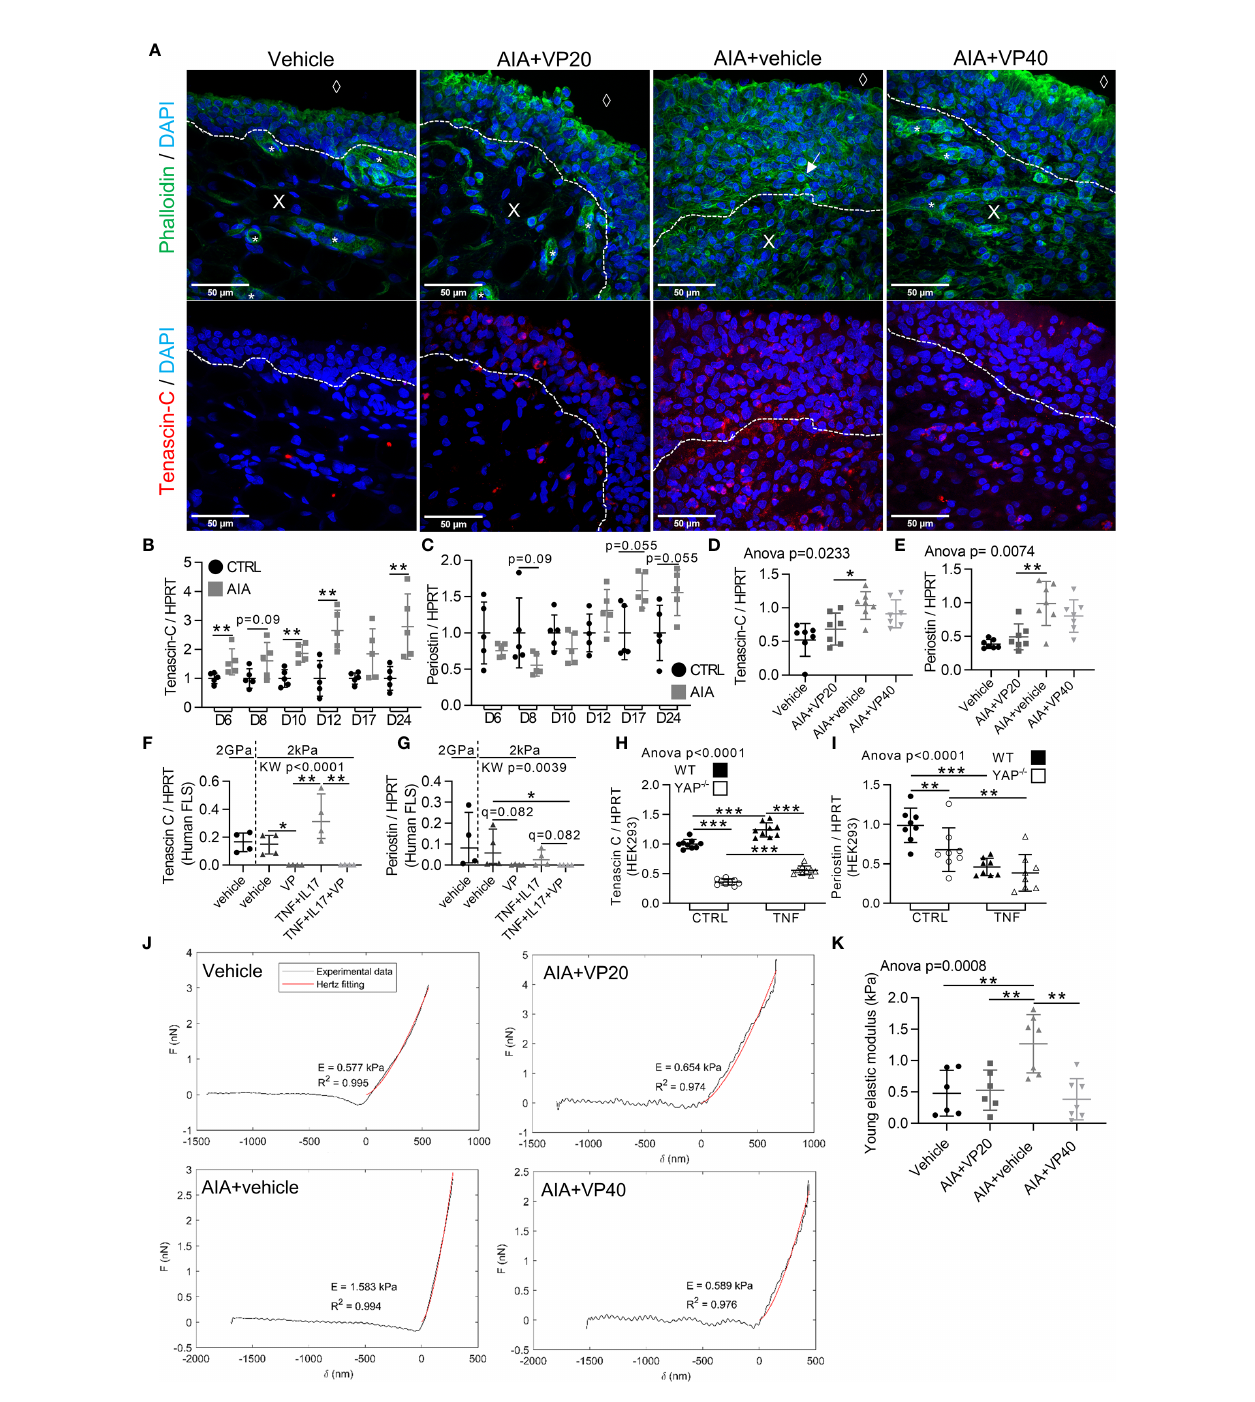
FIGURE 6 | Increased stiffness of synovial tissue during arthritis under the control of YAP/TAZ. Samples used for in vivo experiments were described in Figures 1 and 4 . RA FLS (n=4 patients) were used as described in Figure 2 . HEK293 results are representative of three independent experiments (n=9 per group). (A) Representative confocal tiled images of tenascin-C (red), counterstained with DAPI (blue) and phalloidin (green) in synovial membrane of rat AIA model; dotted lines: limit between synovial lining layer and synovial stroma; X: stromal compartment; diamond: synovial fl uid compartment; star: blood vessels; arrow: actin stress fi ber. (B – I) RT-qPCR results for tenascin-C and periostin in AIA and control rats ankle with different kinetics (B, C) VP AIA treated rats ankle (D, E) ; RA FLS (F, G) or HEK293 WT and YAP -/- cells (H, I) . (J) Representative punctual nanoindentation curves for rat synovial membrane using AFM. Increased slope corresponded, when fi tted with Hertz model (red), to an increased Young ’ s modulus (indicated as E ) (K) Corresponding quanti fi cation of Young ’ s modulus (kPa). Data were presented as individual values with mean ± SD (D, E, H, I, K) or median and interquartile range (B, C, F, G) with Kruskal Wallis or ANOVA test with FDR post hoc test corrected (q-value) for multiple comparisons *q < 0.05; **q < 0.01; ***q < 0.001. TNF,